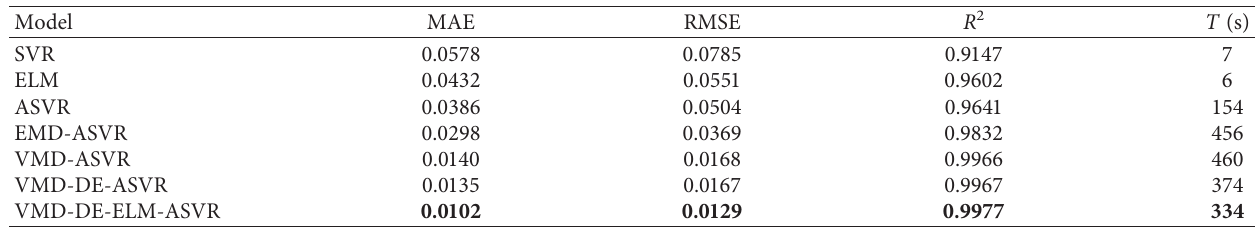
Figure 15: (a) Error box diagram of each model; (b) bar chart of model error index. M1: SVR; M2: ELM; M3: ASVR; M4: EMD-ASVR; M5: VMD-ASVR; M6: VMD-DE-ASVR; M7: VMD-DE-ELM-ASVR. Table 4: The comparison result of different model performances for data set